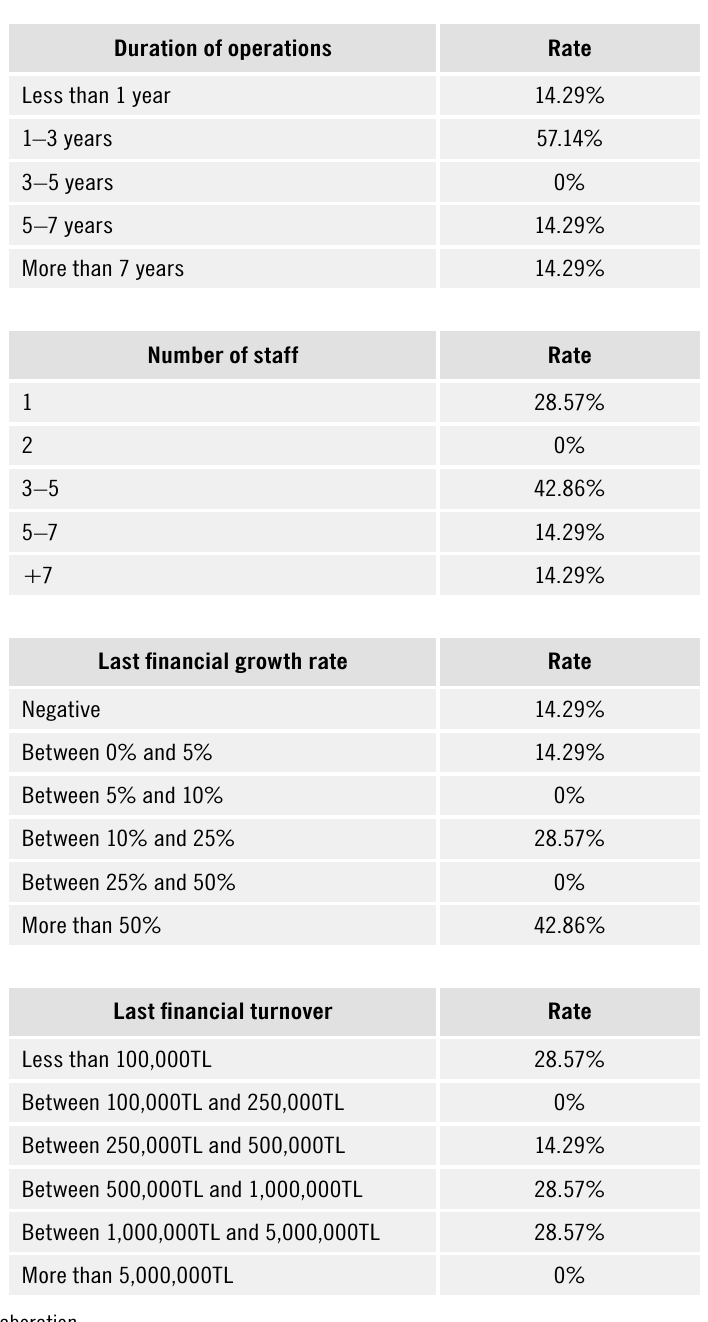
Table 5. Results of performance measures of the respondent